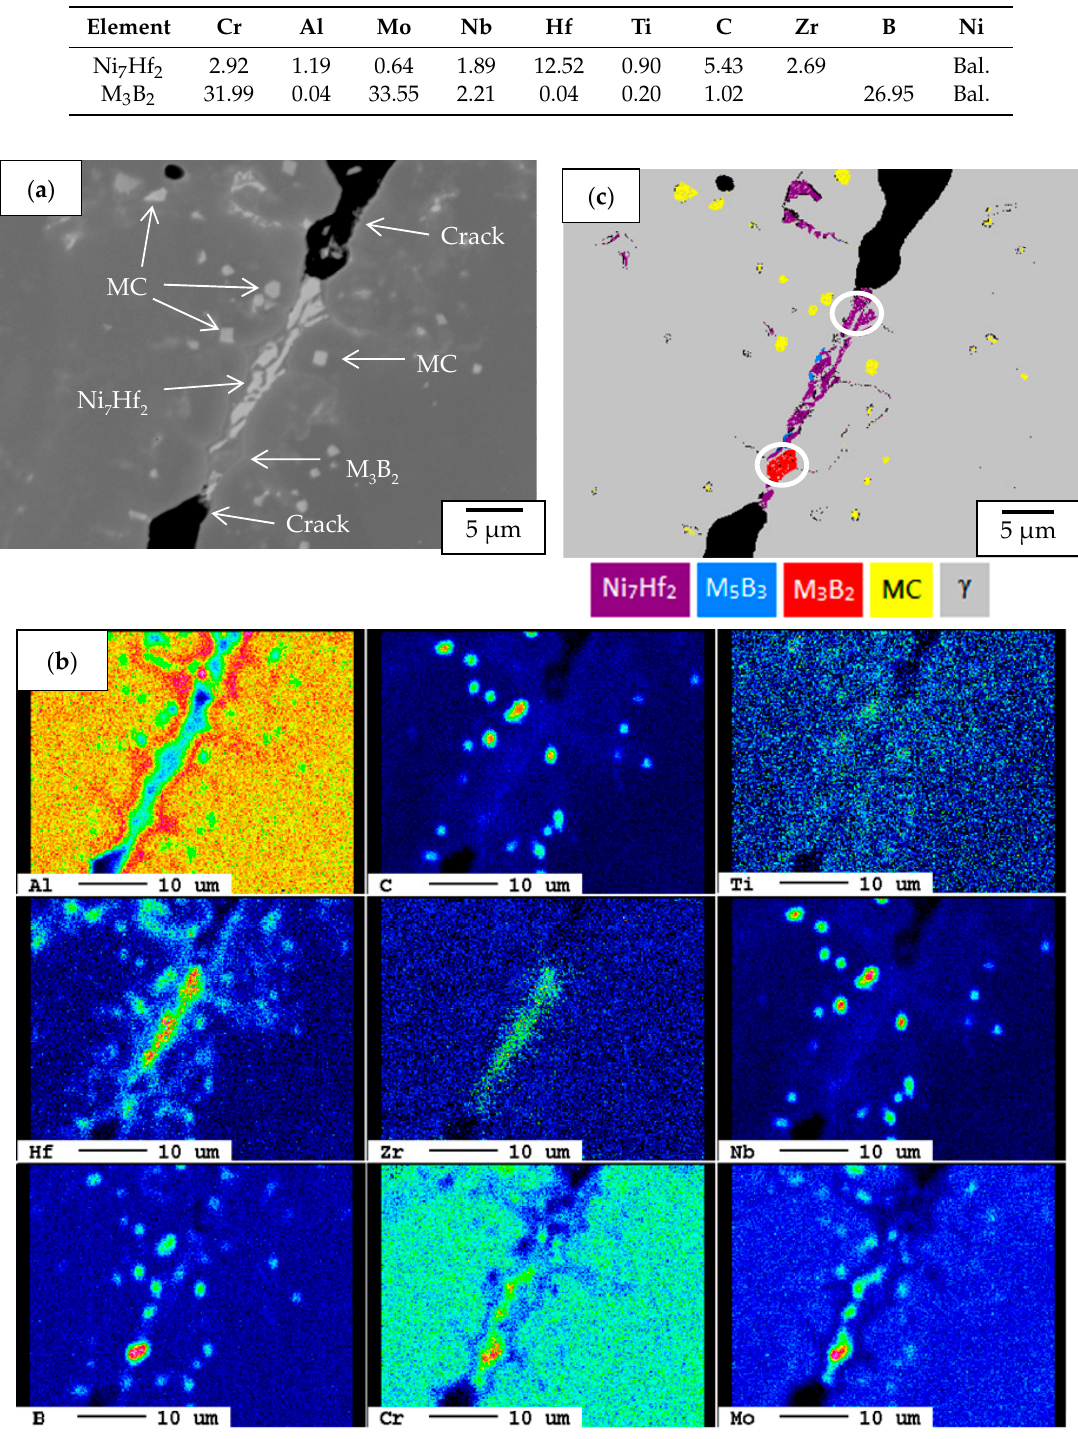
Figure 7. ( a ) BSE image of FESEM showing the microstructures ahead of liquated cracks and ( b ) the EPMA element maps; ( c ) EBSD map to identify distinct phases.